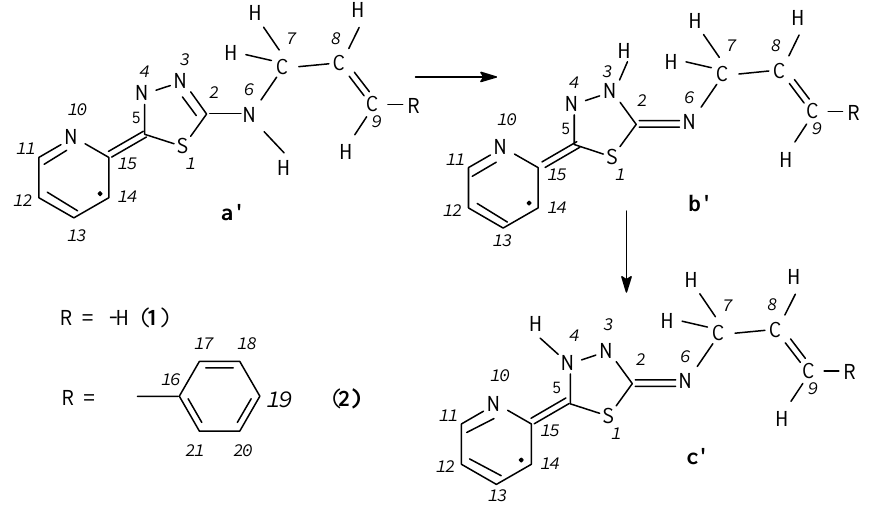
Figure 2 . Tautomers a’, b’ and c’ of allyl- ( 1 ) and 3-phenylallyl-(5-pyridine-2-yl-[1,3,4]- thiadiazol-2-yl)-amine ( 2 ), with atom